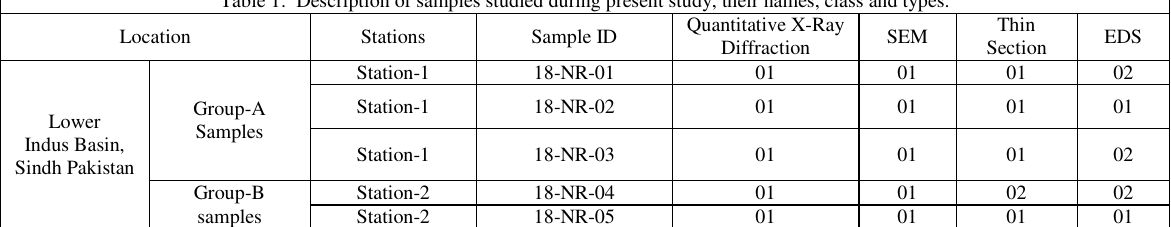
Table 1: Description of samples studied during present study, their names, class and types.